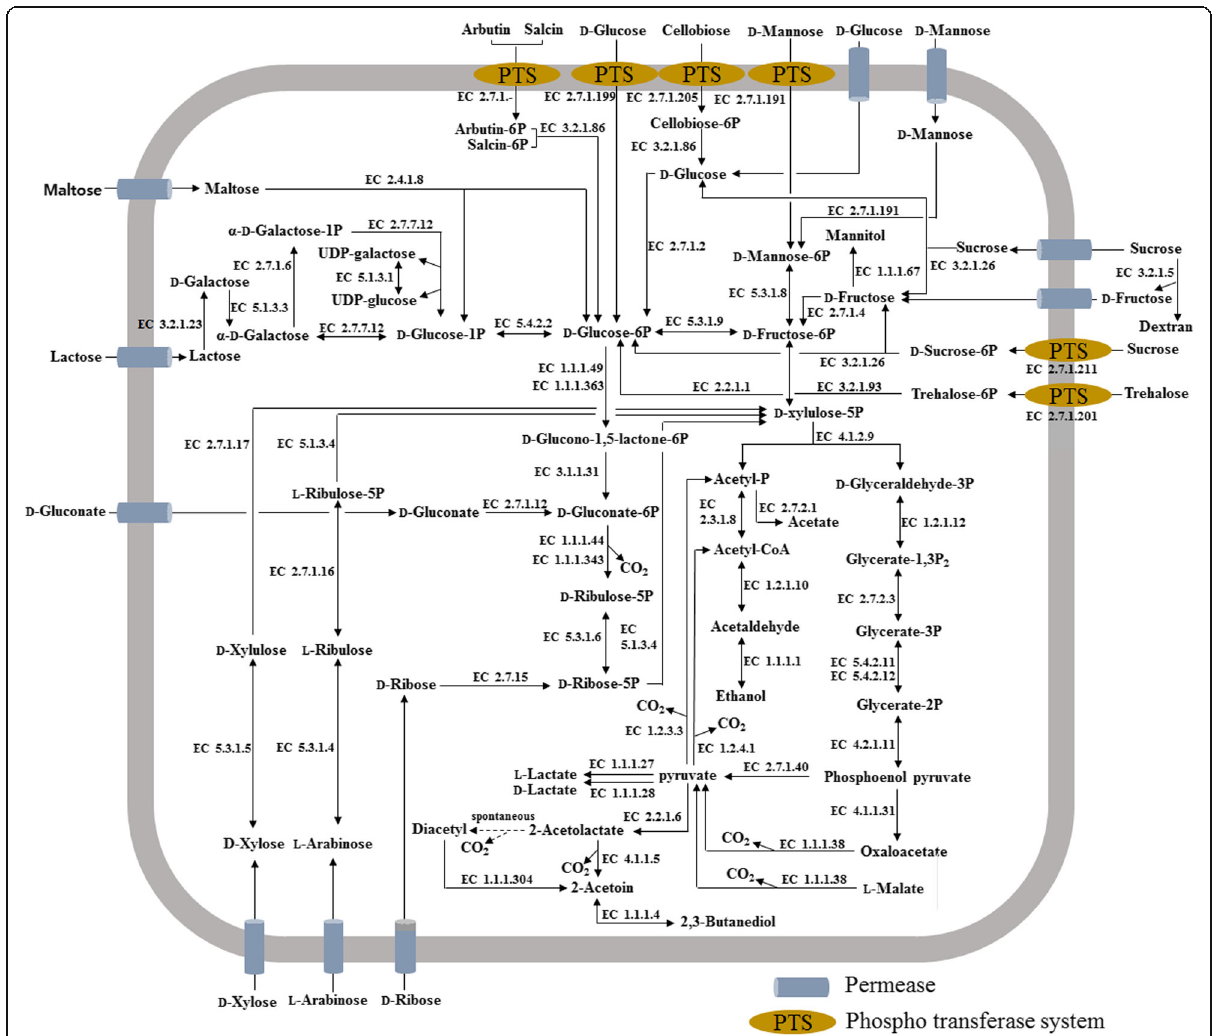
Fig. 5 Predicted fermentative metabolic pathways of various carbon compounds in Leuconostoc suionicum DSM 20241 T during fermentation. PTS, phosphotransferase system; UDP, uridine